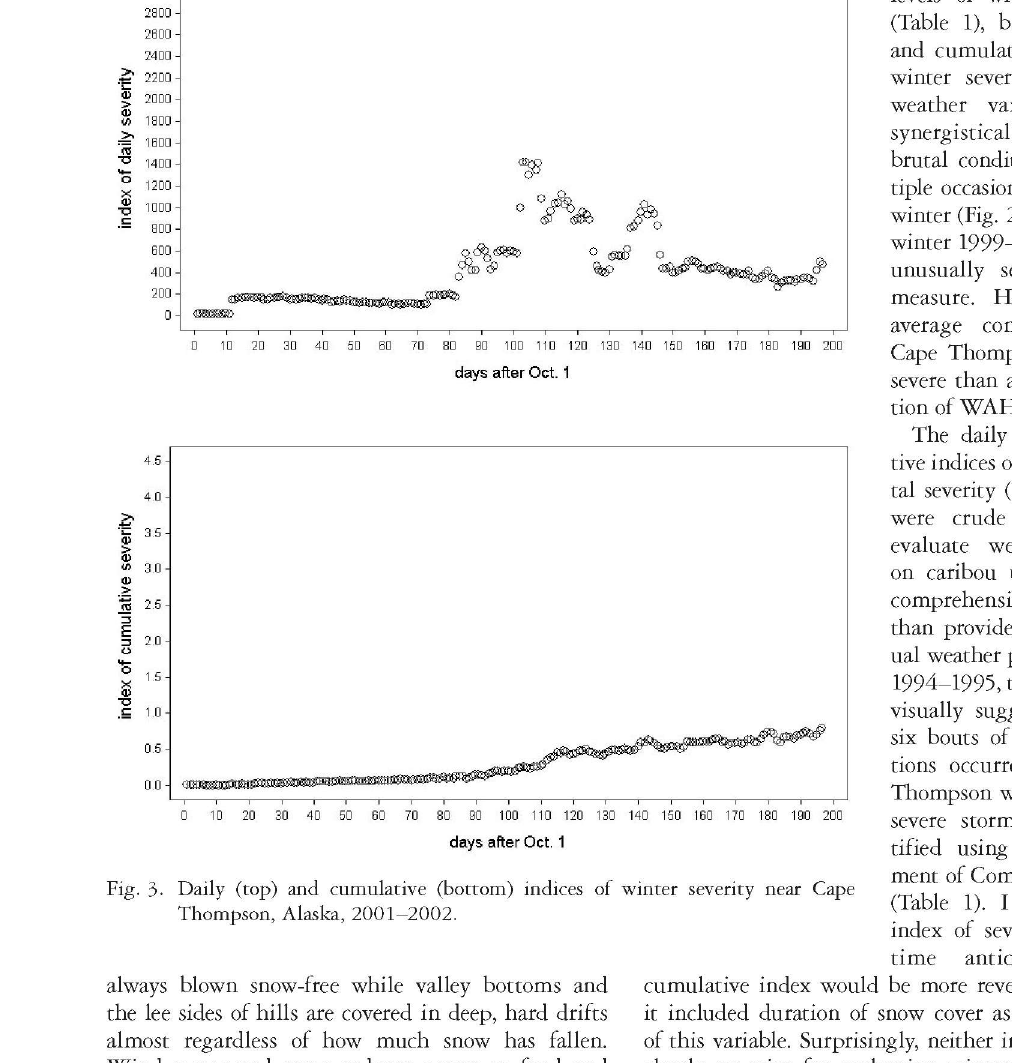
Fig. 3- Daily (top) and cumulative (bottom) indices of Thompson, Alaska, 2001-2002.